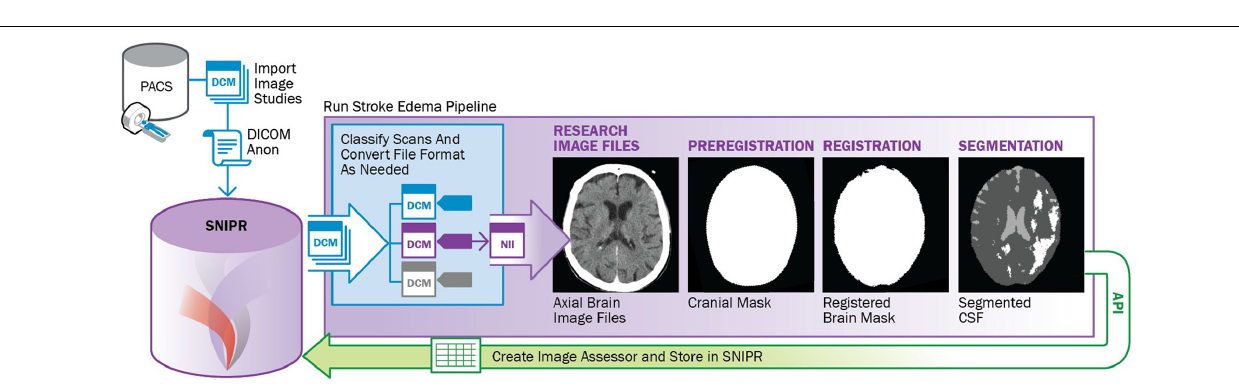
Frontiers in Neuroinformatics |